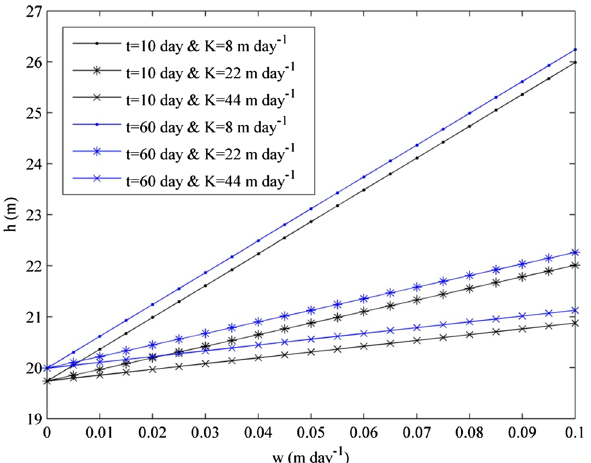
Fig. 9 Variation in hydraulic heads due to changes in recharge rate with different values of thickness